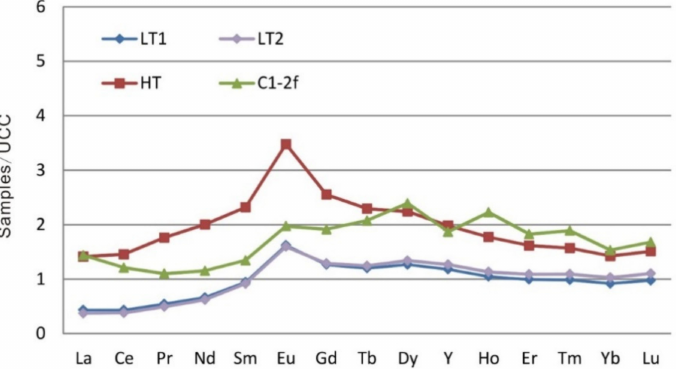
Figure 25. REY distribution patterns normalized to the Upper Continental Crust (UCC) [87] for the C1-2f sample and high-Ti and low-Ti alkali basalts of the Emeishan Province (data from Xiao et al.